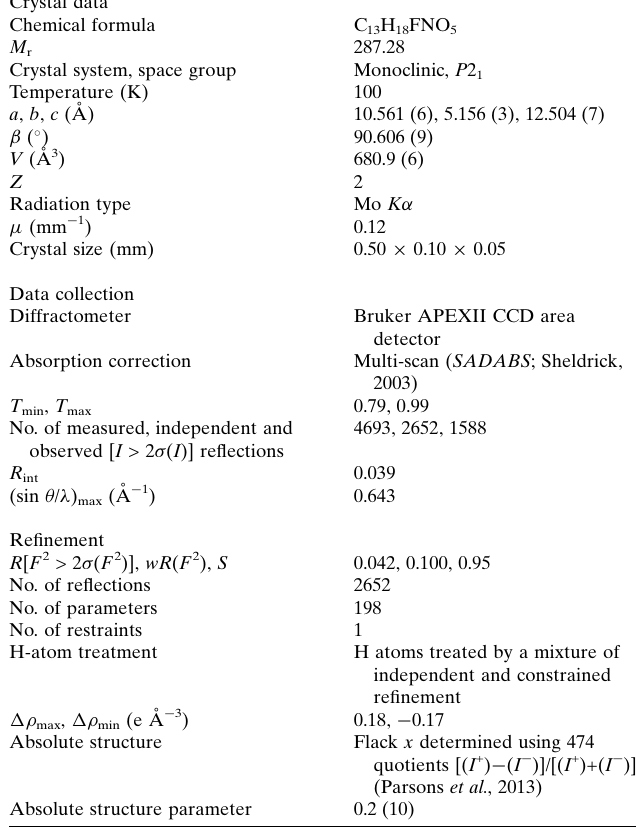
Table 4 Experimental